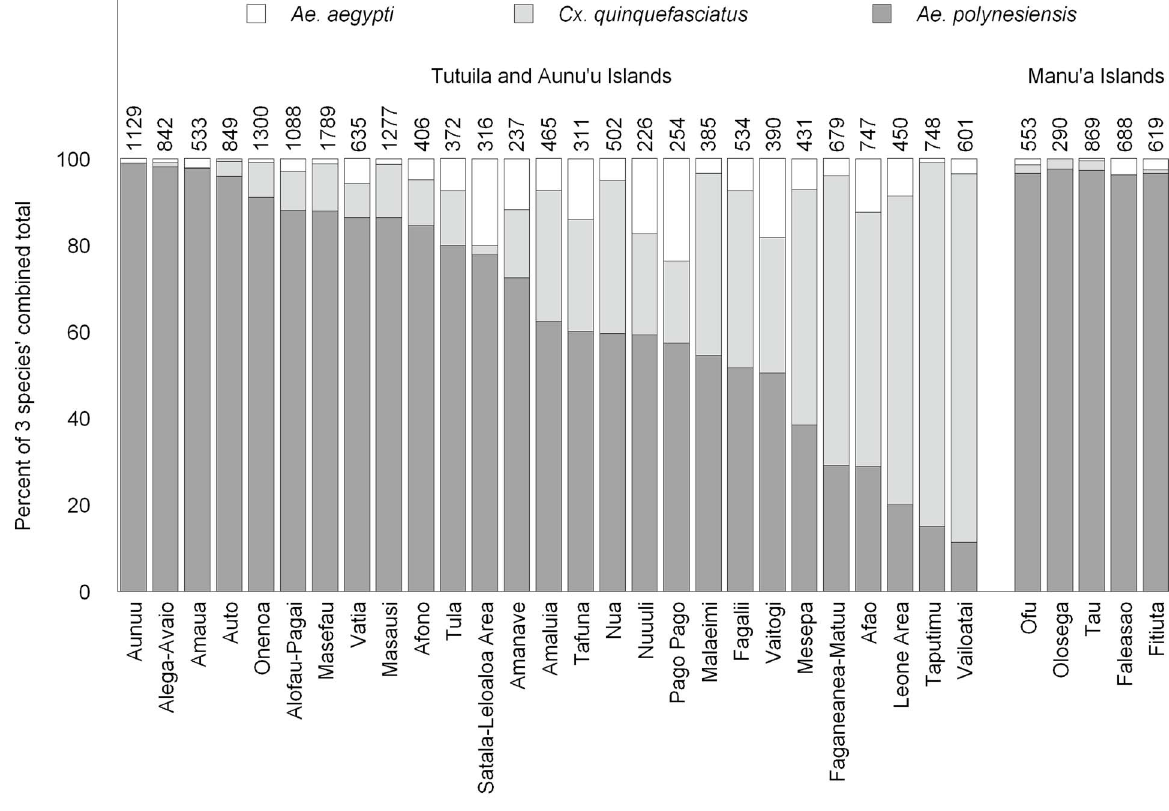
Figure 2. Catch of the three most numerous mosquito species which had . 1 positive pool overall as a percentage of those three species’ combined total in each village. The number above each bar is the combined total number captured of the three species. Ten traps were operated for 1–2 days in each village, except in Alega-Avaio and Amaua in which six and four traps were used, respectively. ‘‘Satala-Leloaloa Area’’ includes Satala, Anua, Atuu, and Leloaloa villages and ‘‘Leone Area’’ includes Auma, Leone, and Puapua